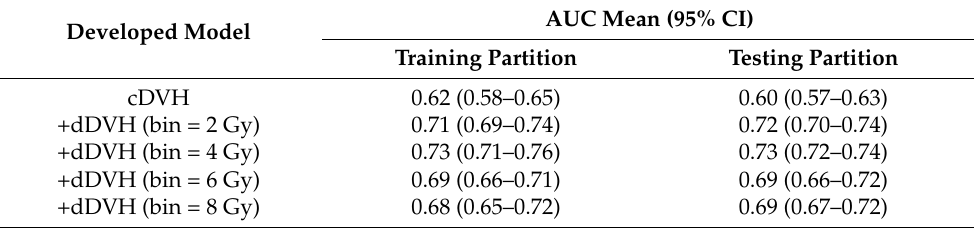
Table 2. Mean and 95% CI interval of the AUC on training and testing data sets for the cDVH model and +dDVH models.